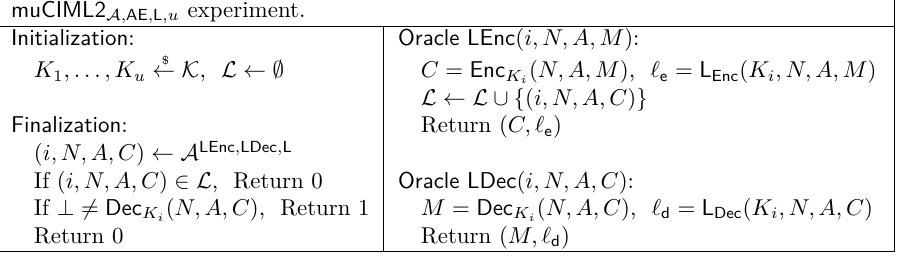
Table 14: Ciphertext integrity with nonce misuse and leakage in enc. & dec. experiment. muCIML2 A , AE , L ,u experiment. Initialization